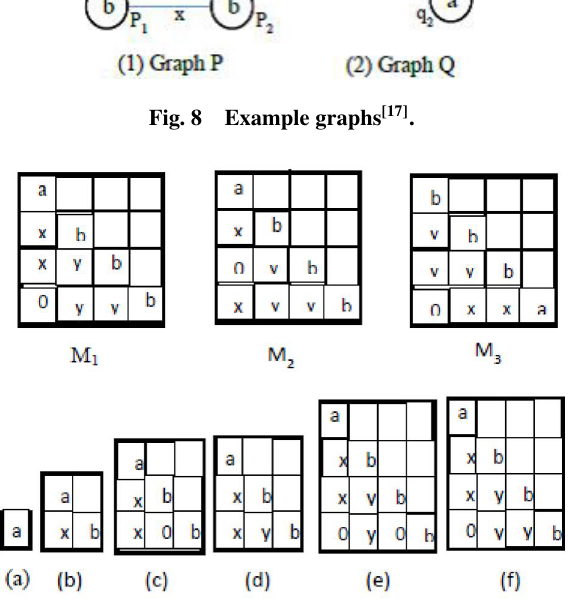
Fig. 9 Canonical adjacency matrices [17] .